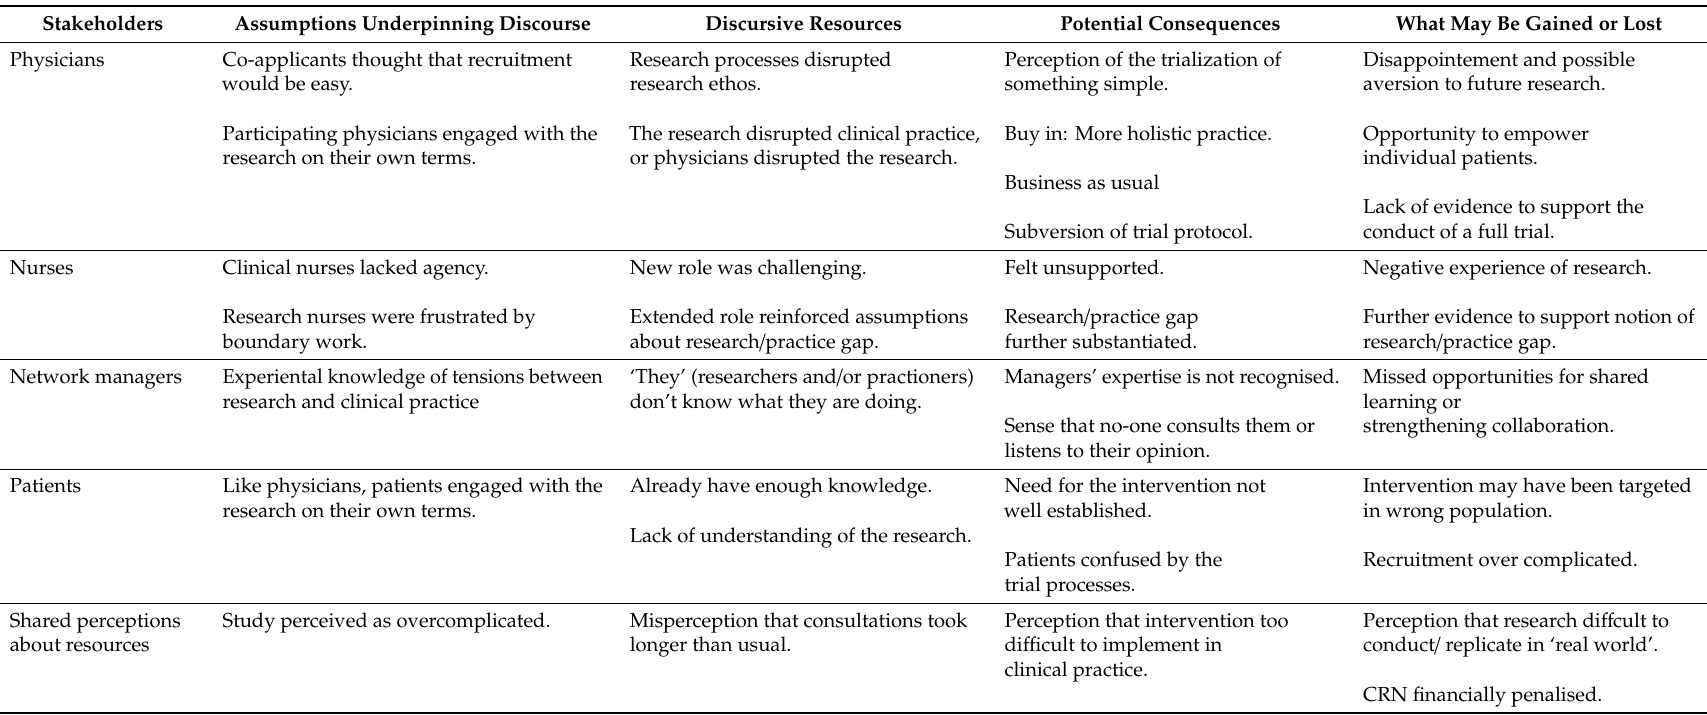
Table 1. Discourses employed by stakeholders in di ff erent